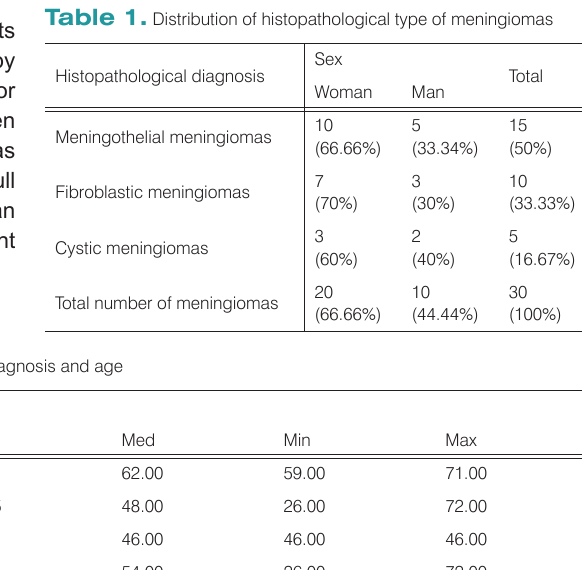
Table 1. Distribution of histopathological type of meningiomas